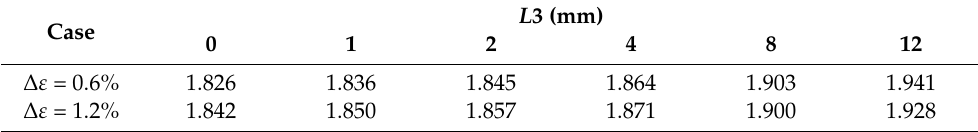
Table 9. JRC specimen ( L 3 length effect on S2G values, FEM INCEFA ).